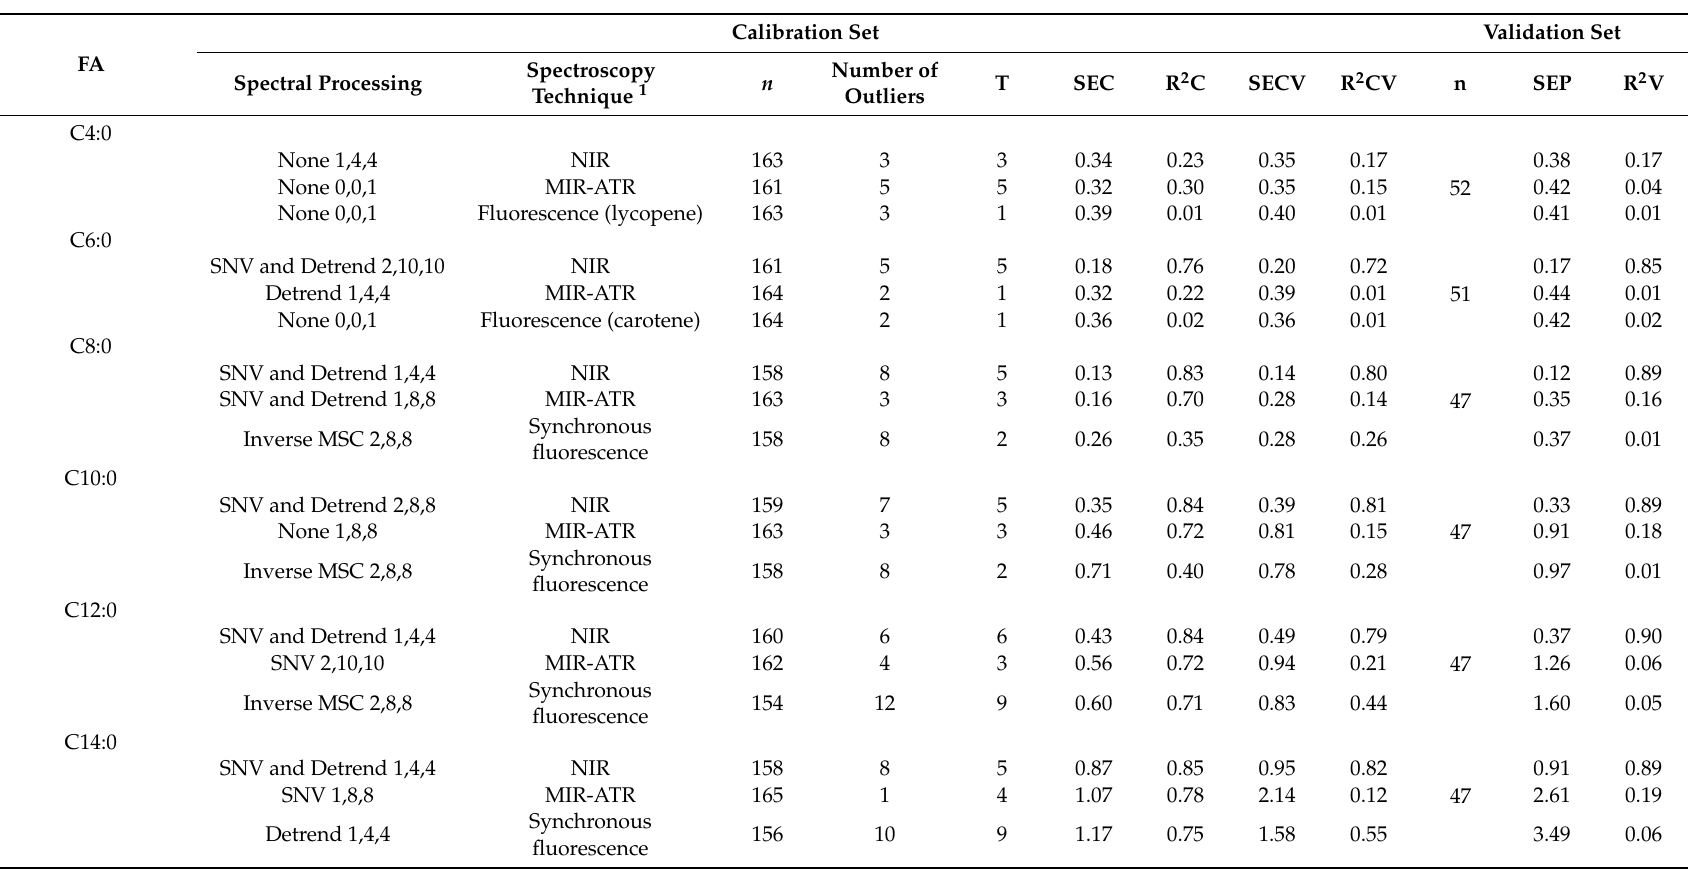
Table 5. Prediction of di ff erent fatty acids (FA, expressed in g / 100g of the total FA) in cow milk according to the equation developed from three spectroscopy techniques: near-, mid-infrared (NIR and MIR, respectively) and fluorescence